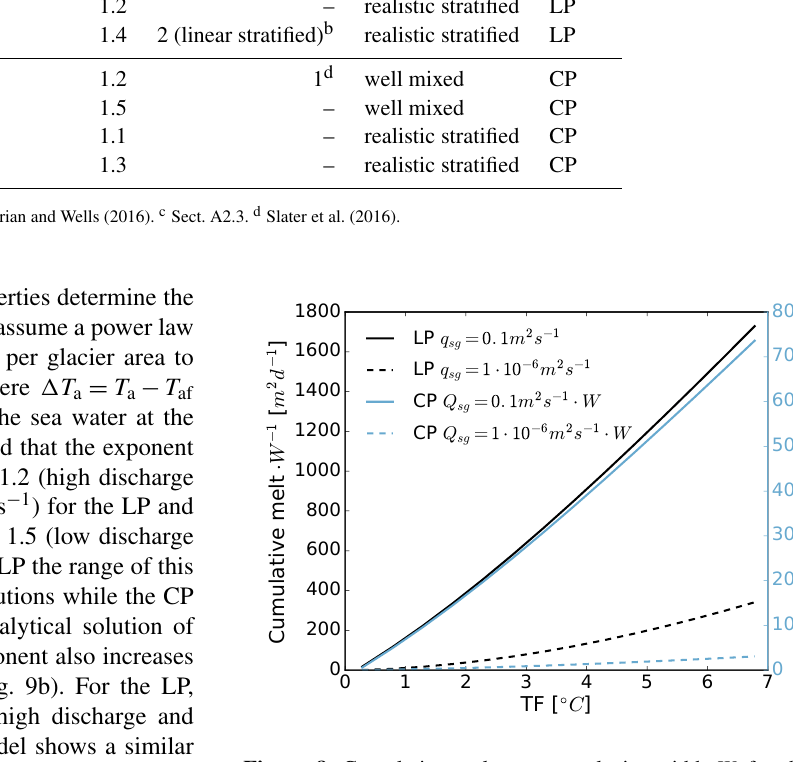
Figure 8. Cumulative melt rate per glacier width W for the LP model (black) and CP (blue) model as a function of the thermal forc- ing ( (cid:49)T a = T a − T af ) for high (solid lines) and low (dashed lines) discharge values. The experiment is for a well-mixed, 500m deep and 5km wide tidewater glacier (sin (α) = 1), with S a = 34psu and E 0 = 0 .